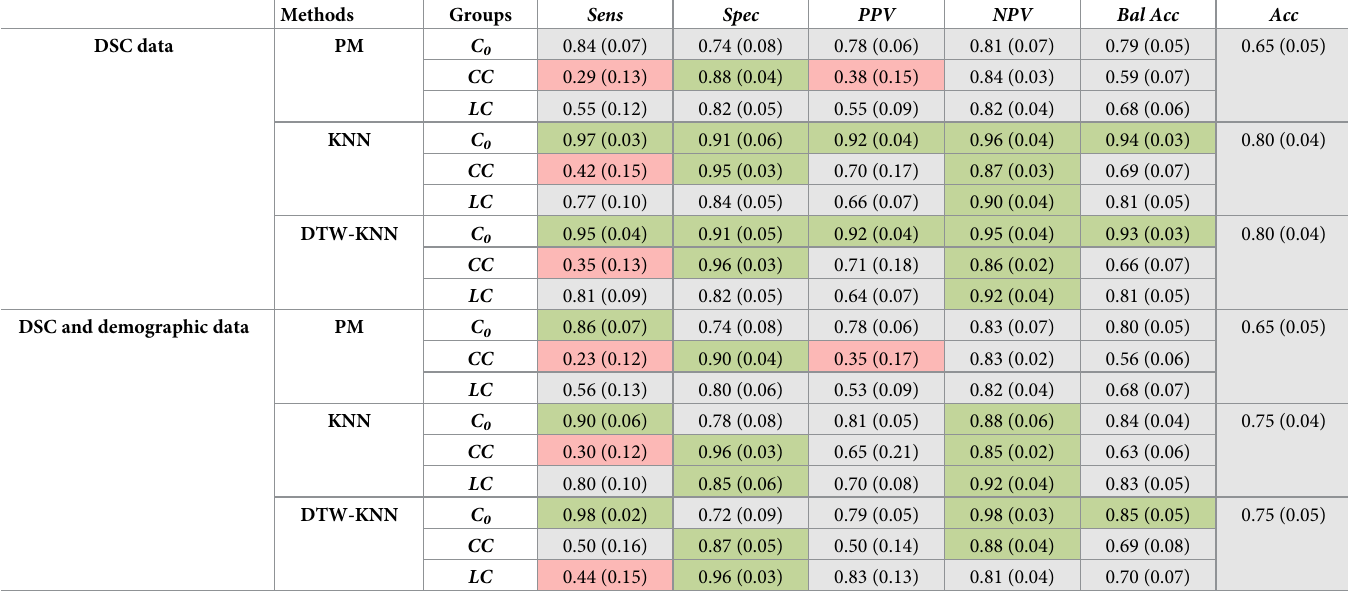
Table 5. Results of three group classification